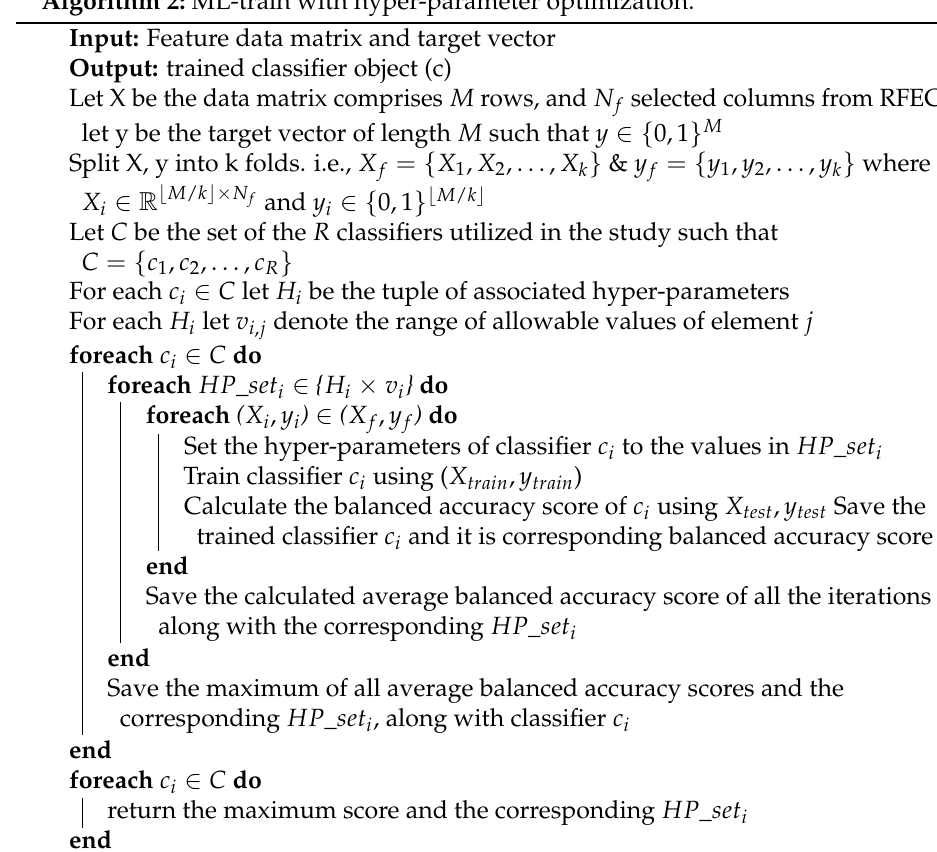
Algorithm 2: ML-train with hyper-parameter